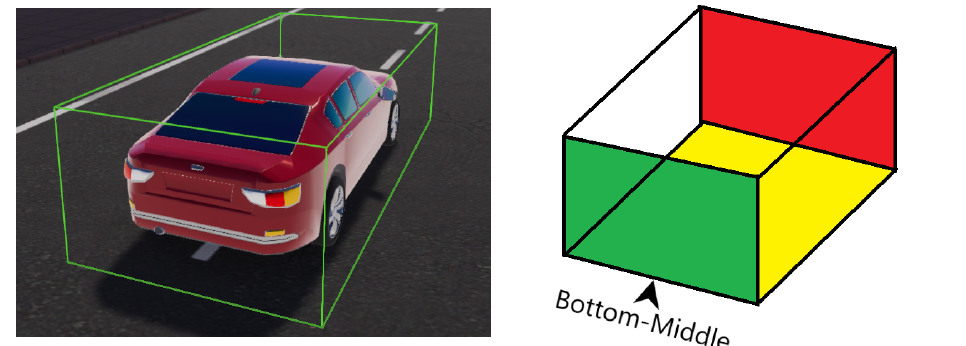
Figure 3. On the left side, a 3D bounding box is constructed based on the road user projected on the image plane. On the right side, green, red, and yellow represent the back, front, and bottom of the object, respectively. When the detection algorithm of a sensor provides a 3D bounding box, in general, any point in the 3D box can be selected as the detected position of the traffic user. For object list-based sensor fusion, however, it needs to be ensured that the different sensors deliver an object list where the same position can be